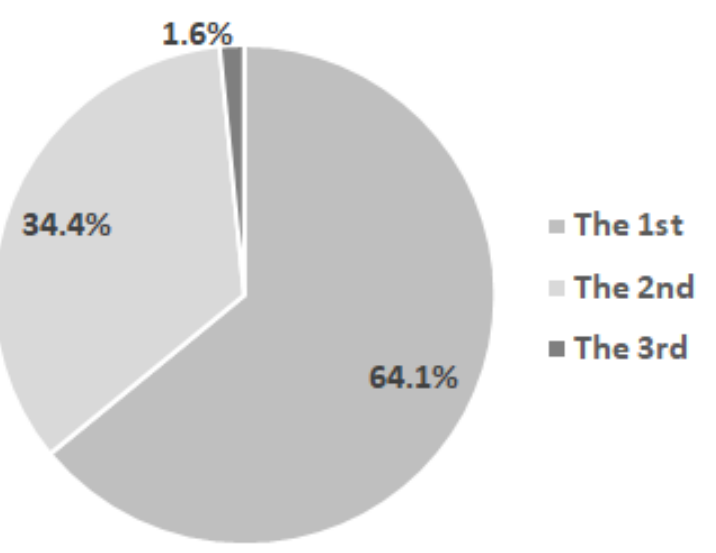
Figure 2. Distribution of children by place in the sequence of sibling births. Of the total number of children for whom the Apgar score was completed, more than half received the score of 9 (54%) and a good portion (40%) received the Apgar score of 10. Only three children received a lower Apgar score (7 and 8) (Figure 3).